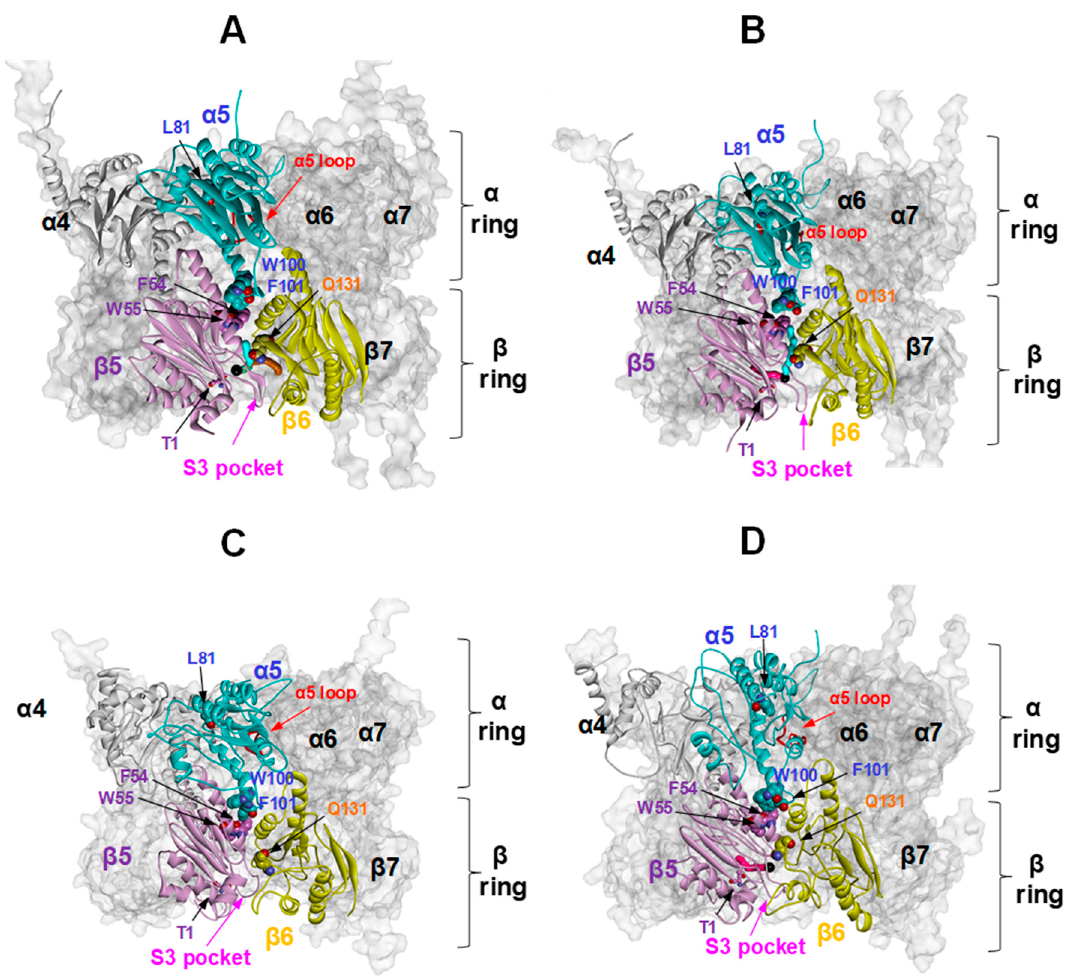
Figure 13. h20S proteasome tunnels at the catalytic β 5-Thr1. α 4 / α 5 and β 5 / β 6 are shown in the foreground to focus on the tunnels generated around β 5-Thr1 in closed ( A ) and open ( B ) 20S state and upon binding of three Tris-T4 molecules starting from the closed ( C ) and open ( D ) 20S state. α 4 / α 5 and β 5 / β 6 are rendered in solid cartoons ( α 4 = grey, α 5 = cyan, β 5 = pink, and β 6 = green) whereas the whole body of the 20S proteasome is displayed in transparent surface; α 5-loop is shown in red cartoons. A black solid ball evidences starting tunnel position; the tunnels are coloured in cyan, brown, and magenta. Catalytic Thr (T1) and key amino acids involved in the allosteric network described by Ruschak et al. [20] are labelled and shown in CPK with the same color of the corresponding subunit.